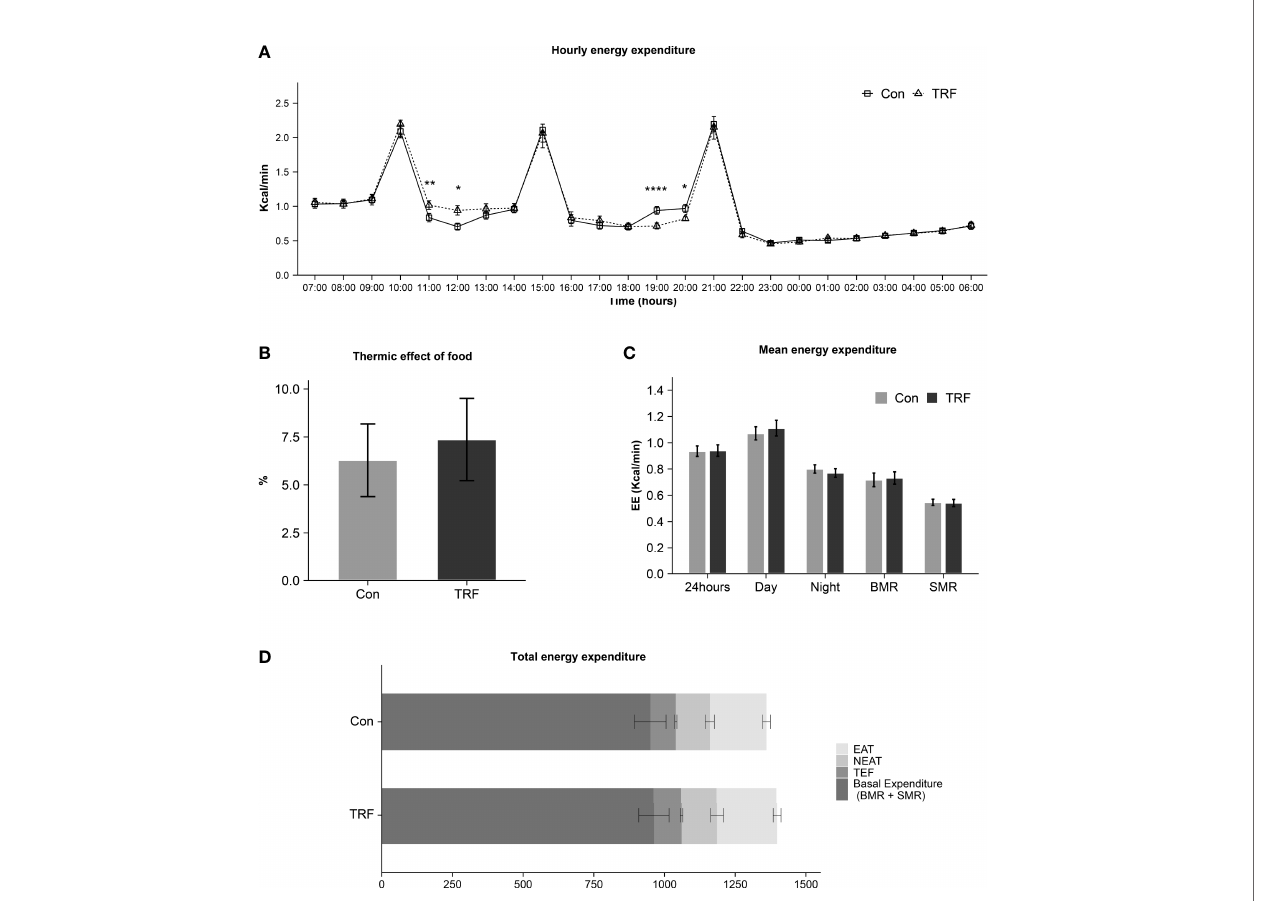
FIGURE 2 | Hourly energy expenditure (A) , thermic effect of food (B) , mean energy expenditure (C) , and total energy expenditure (D) between control and TRF groups. Data are mean ± SEM, *P <0.05, **P<0.01, ****P ≤